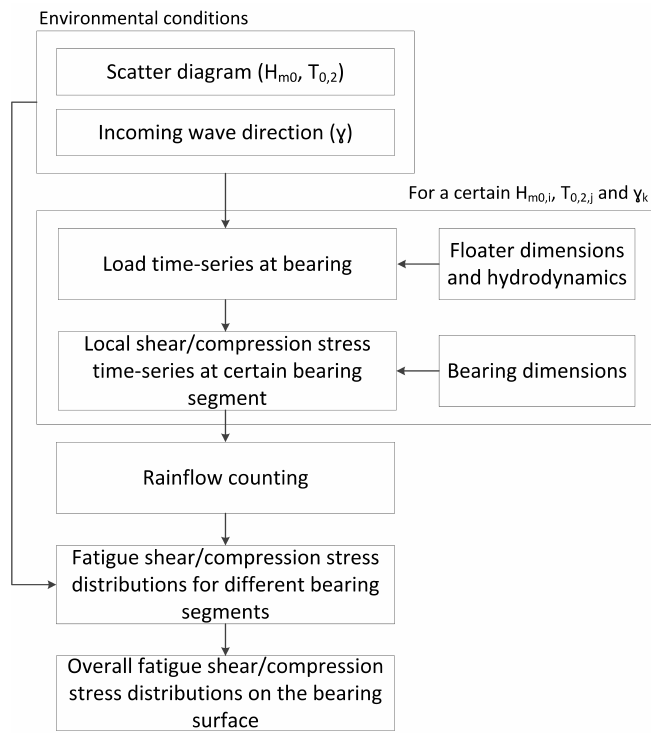
Figure 6. Flow chart of the procedure to calculate fatigue surface stresses at different locations on the bearing surface.